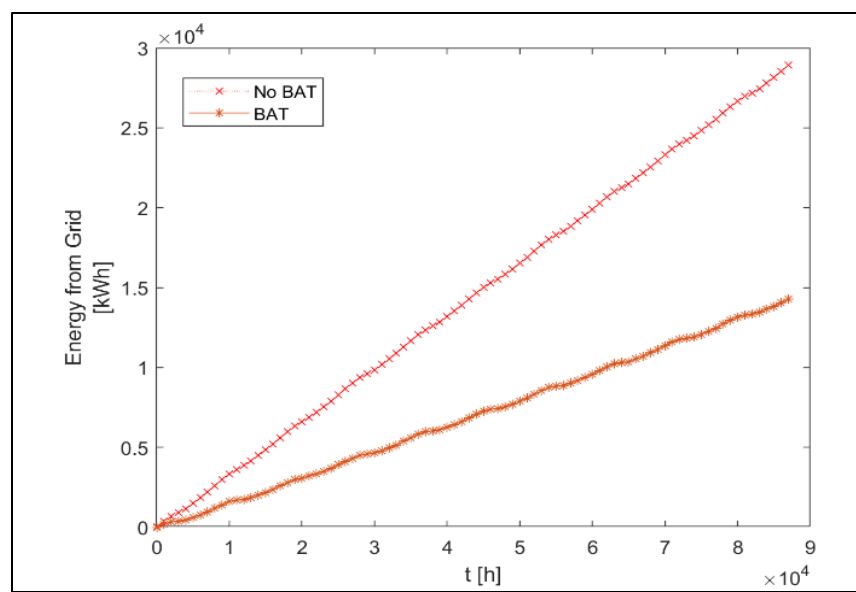
Figure 16. Expected progressive energy required from the grid.